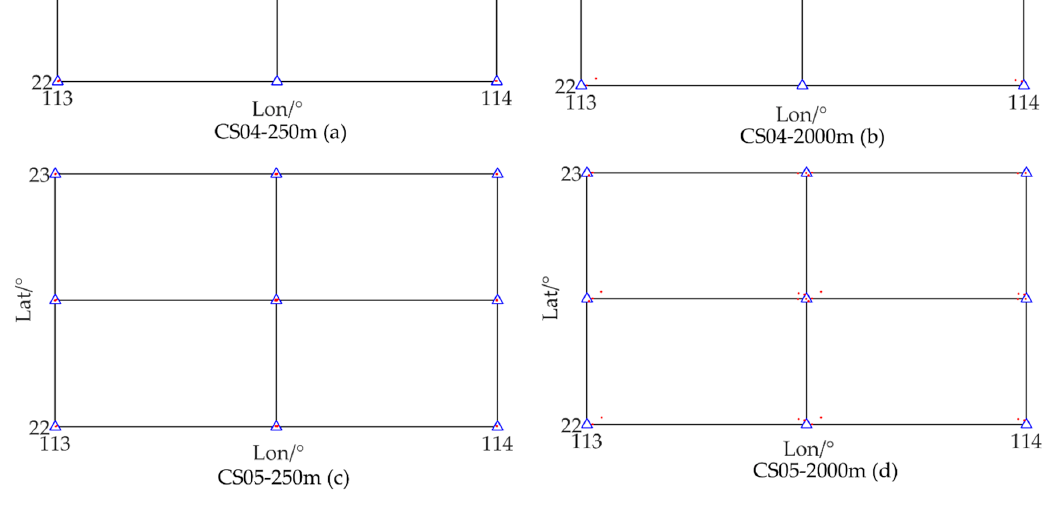
CS04 CS05 CS06 CS07 Figure. 8 Comparisons of wet refractivity error profiles for CS04, CS05, CS06, and CS07 for a study of influences of ground-based station distribution and horizontal resolution on tomography. Average Nw error is about 6.57 and 6.27 mm/km in CS05 and CS06 at the lowest layer, with